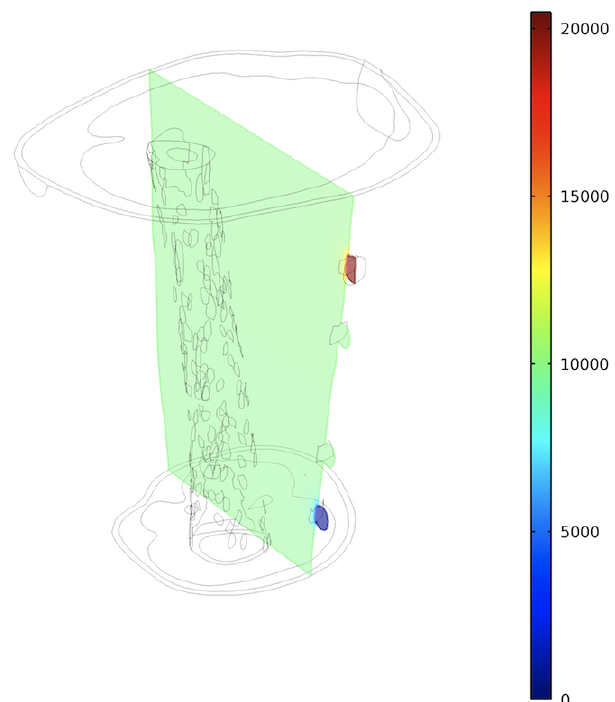
Fig. 26: Slice plot of potential generated by injecting 1 A through the CC